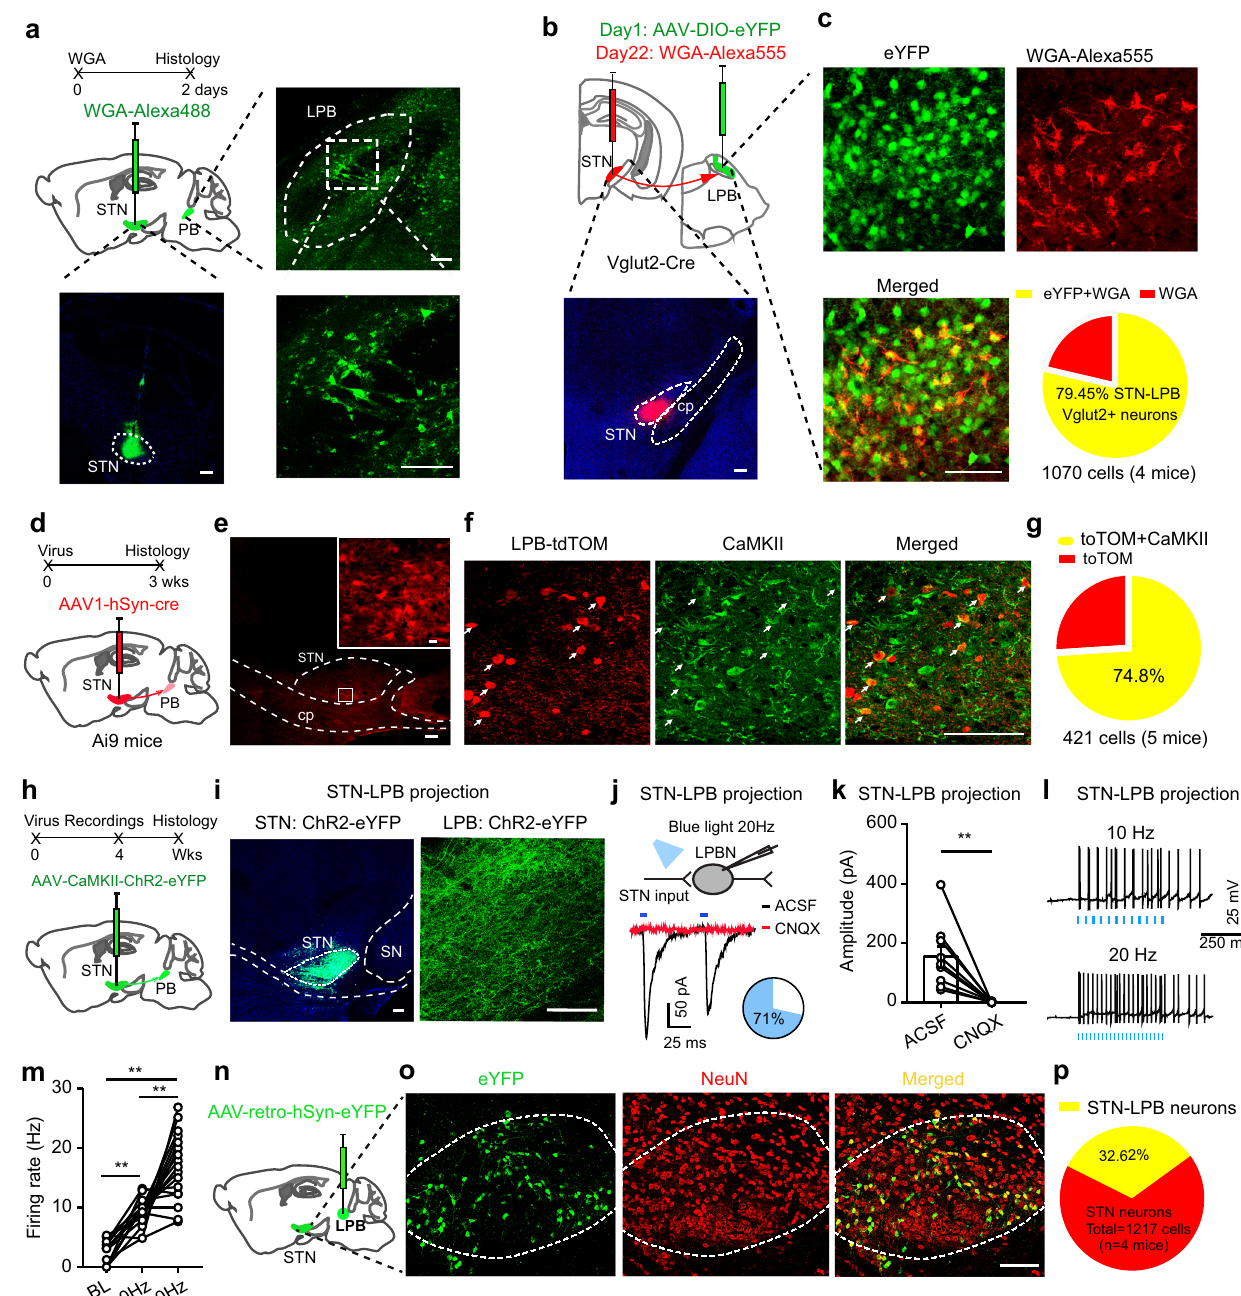
Fig.3|STN Glu neuronsdirectlyinnervateLPB Glu neurons.a Anterogradelabeling of lateral parabrachial nucleus (LPB) neurons from the STN. b Experimental dia- gram for labeling LPB glutamatergic neurons (upper) and an example image showing the WGA injection in the STN (lower). c Colocalization of WGA and Vglut2 in LPB neurons and the quanti fi cation pie chart. d Anterograde labeling of LPB neurons from the STN with scAAV1-hSyn-Cre. e Example images of an AAV1- CreinjectionsiteintheSTN. f – g ColocalizationoftdTomato(tdTOM)andCaMKII in the LPB ( f , representative images; g , quanti fi cation). h , i Viral vector was injected in the STN to label STN neuronal somata and projections to the LPB ( h , schematic diagram; i , example images). j Whole-cell patch-clamp recordings wereperformedtorecordpostsynapticcurrentsinLPBneuronsevokedbypaired